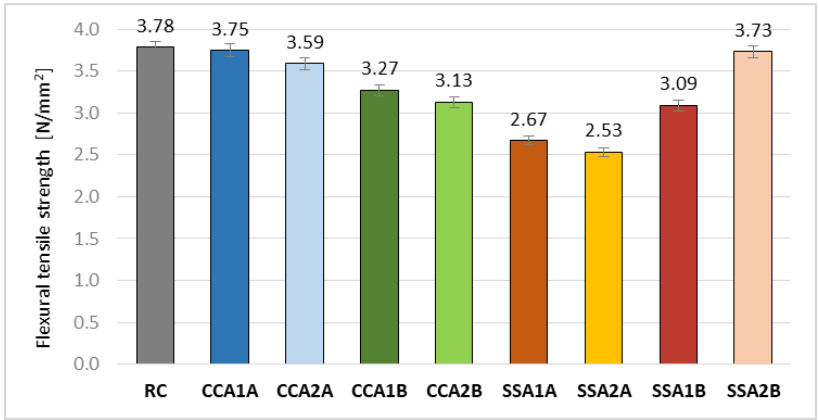
Figure 7. Flexural tensile strength values [N/mm 2 ].